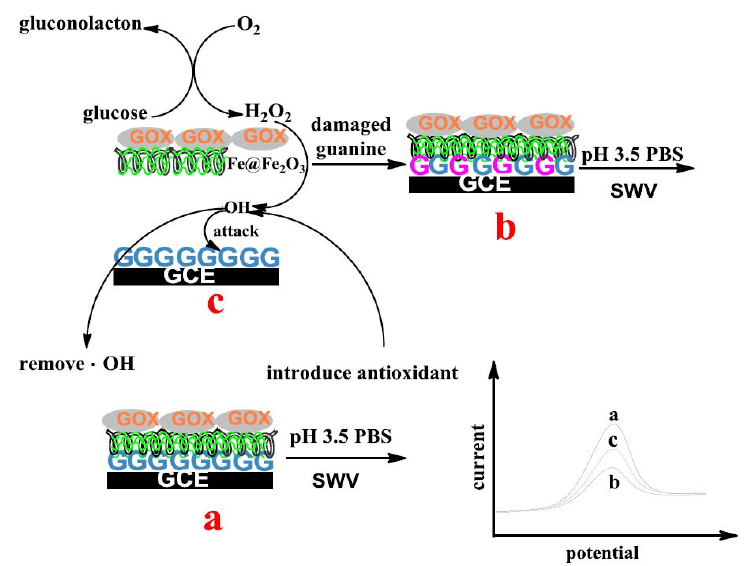
Figure 4. Mechanism of the biosensor and the detection method. SWV (square wave